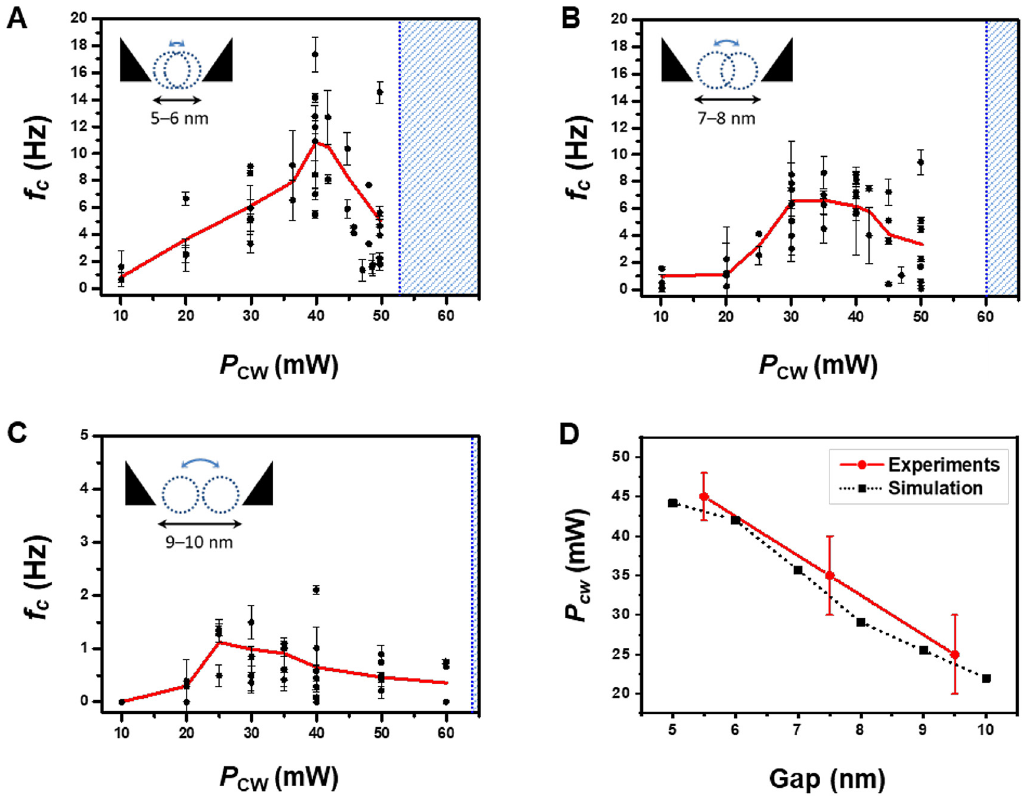
Figure4: Measuredroll-offfrequenciesin(A)groupG1(gapsizeof5 – 6nm),(B)groupG2(gapsizeof7 – 8nm),and(C)groupG3(gapsizeof9 – 10nm)asafunctionoftheCWlaserpower( P CW ).TheerrorbarrepresentsthestandarddeviationofaLorentzian fi ttingerror.Thesolidredlines indicate the average of the roll-off frequencies at each P CW . The vertical blue dotted lines at 53, 60, and 64 mW for group G1, G2, and G3, respectively, indicate the upper limit of P CW due to air bubble generation. (D) Comparison of calculated and measured P CW where the roll-off frequency has a